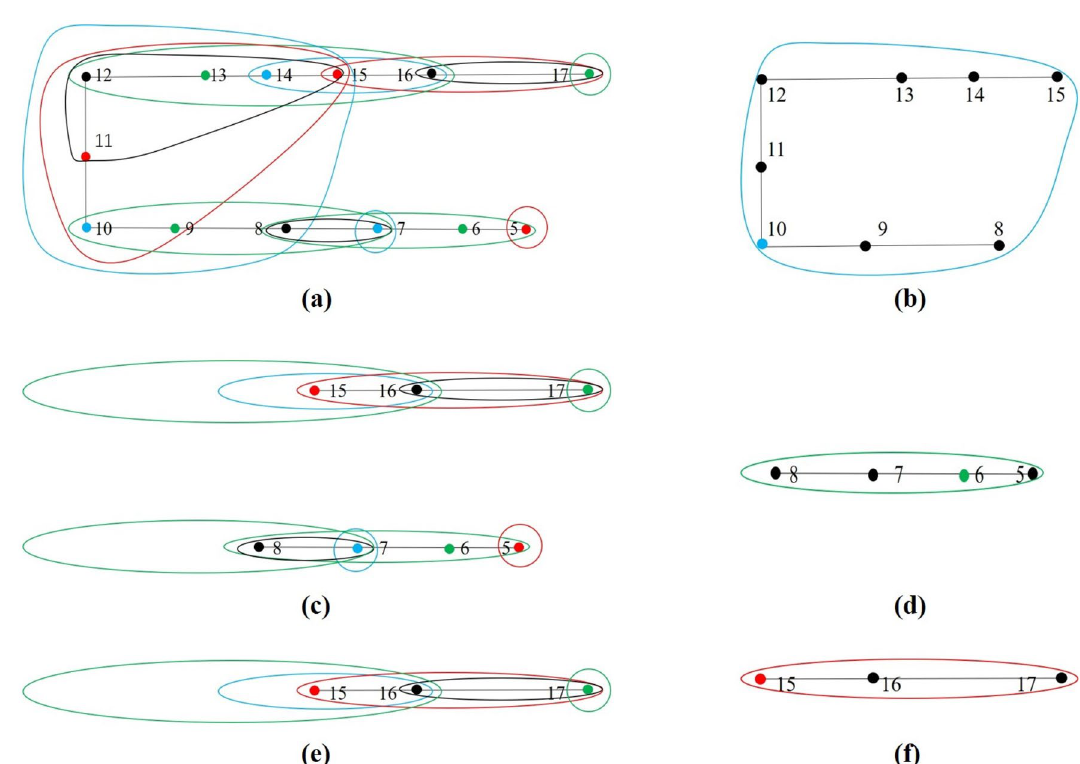
Figure 5. The specific steps of the greedy